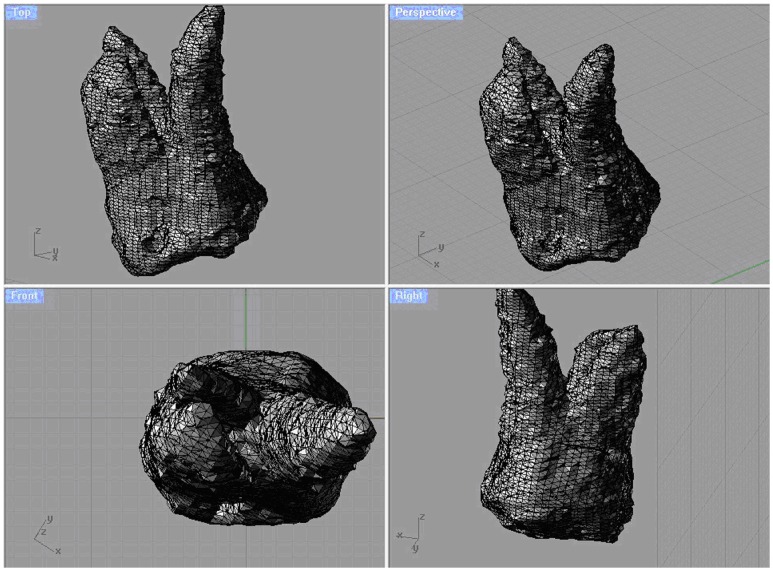
Adjustment of first molar for 3D orientation.